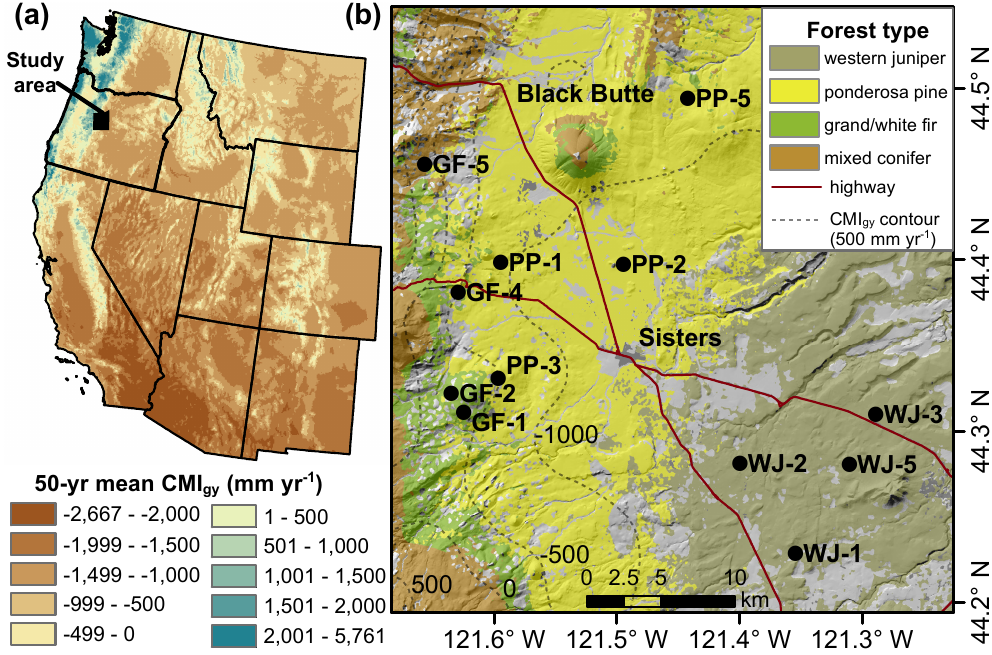
Figure 1. Panel (a) : locator map depicting study area location and mean growing-year climate moisture index from 1964 to 2013 (CMI gy ; mmyr − 1 ) across the western United States. Panel (b) : field sites (points) were located in the eastern Cascade Mountains (Oregon) and spanned three forest types that occur along a steep gradient in CMI gy . Contours (dotted lines) depict CMI gy in 500mmyr − 1 increments. We derived CMI gy from PRISM climate data (Daly et al., 2008), while data on forest type were from Kagan et al.